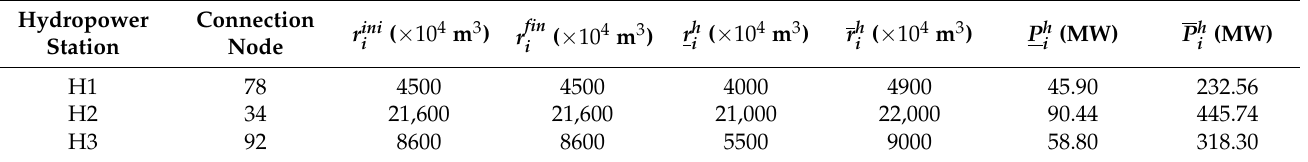
Table A1. Parameters of hydropower stations.